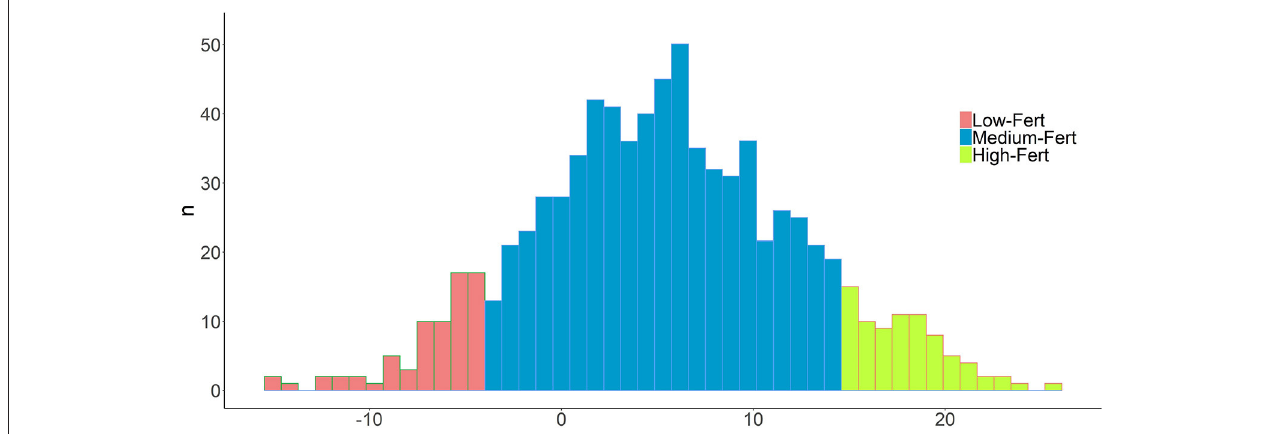
FIGURE 1 | Distribution of Reproductive efficacy pseudophenotypes (Re dEBV ) in the whole population. Values of the top and bottom 10% individuals are shown in green and red, respectively. A normal distribution is followed (Shapiro